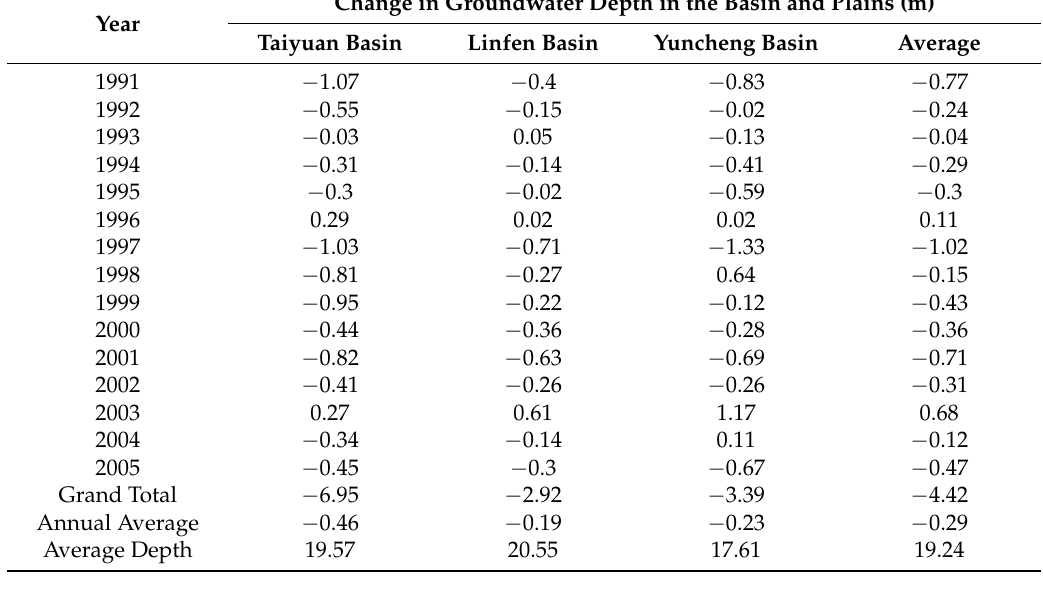
Table 12. Changes in groundwater depth in the Fenhe River basin.